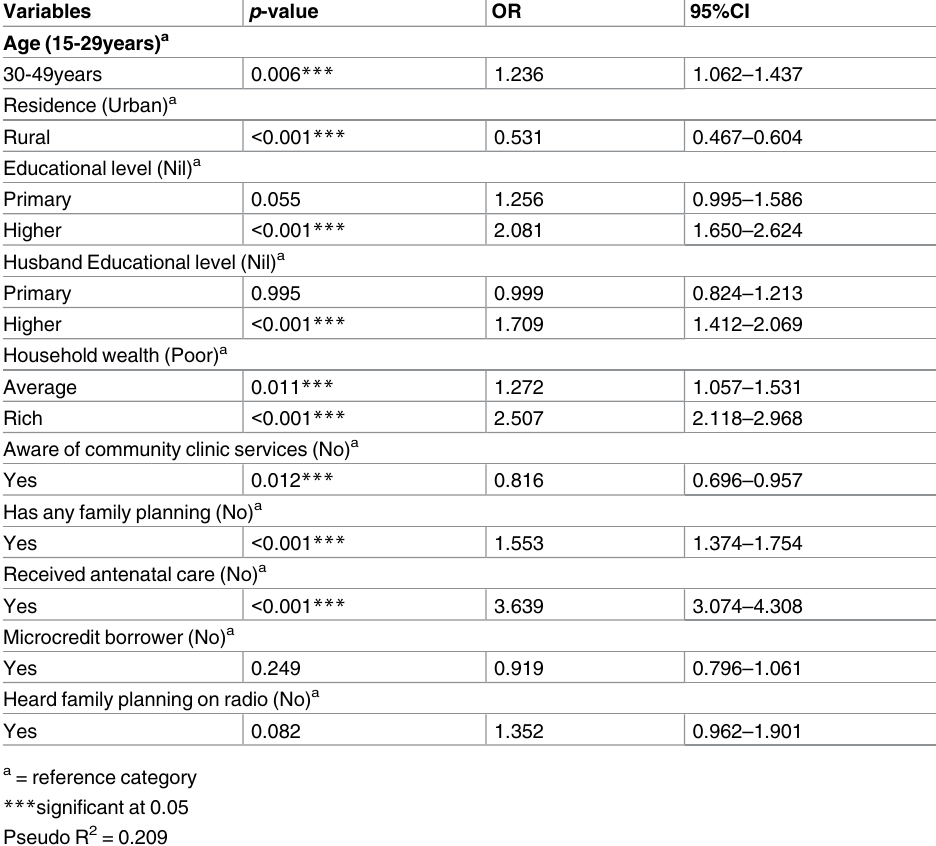
Table 4. Predictors of institutional delivery serviceutilization among Bangladeshi women using con- ditional logistic regression.